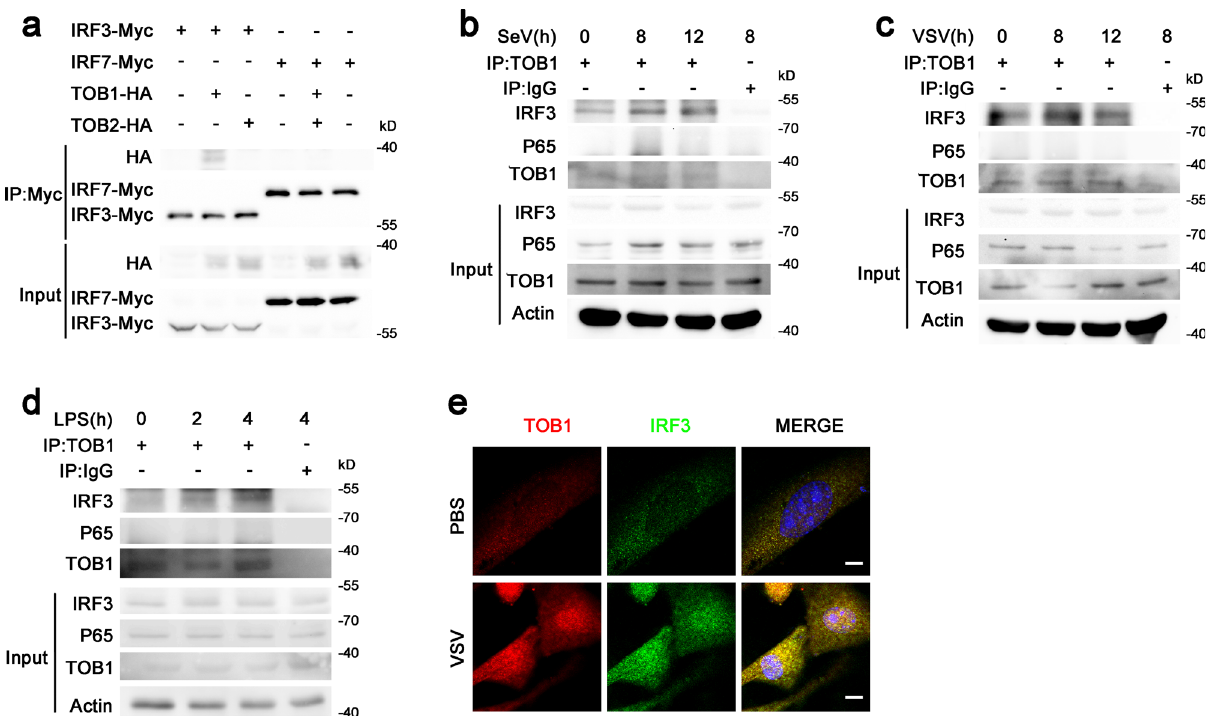
Fig. 1 Viral infection induces TOB1-IRF3 interaction. a Lysates from HEK293T cells transiently transfected with indicated plasmids were subjected to immunoprecipitation with anti-Myc antibody followed by western blot analysis. b – d Lysates from mouse peritoneal macrophages (PMs) stimulated with SeV, VSV, or LPS for the indicated time periods were subjected to immunoprecipitation with anti-TOB1 antibody followed by western blot analysis with anti-IRF3 or anti-p65 antibody. Proteins in the whole-cell lysate were used as the positive control (Input). e Immuno fl uorescence analysis of the colocalization of TOB1(red), IRF3 (green), and nucleus(blue) in MEFs stimulated with VSV. Scale bar, 10 μ m. Data are shown as a representative result from three independent